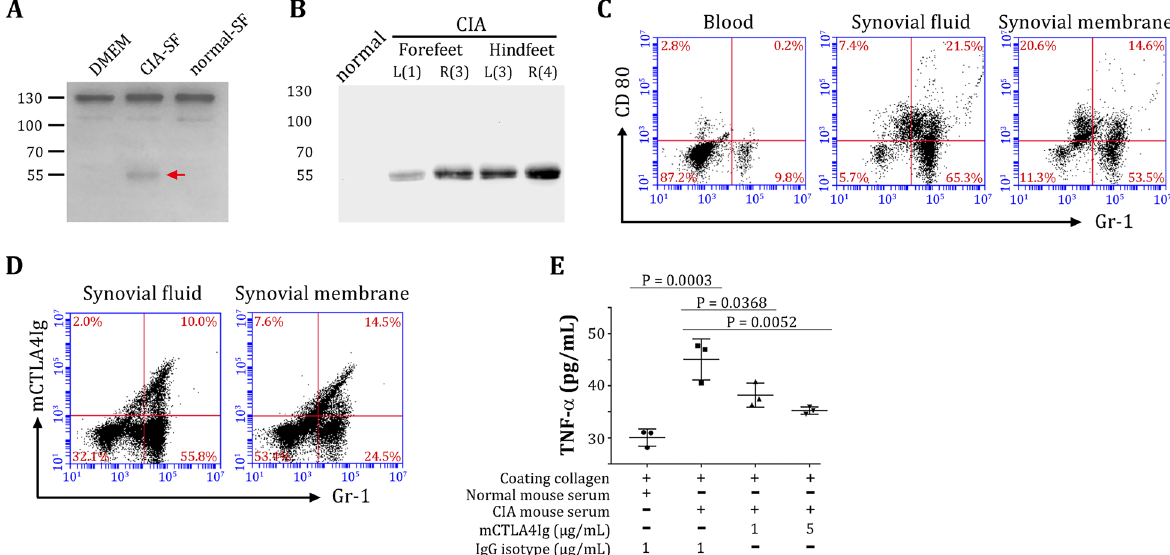
Fig. 6 Conversion of mAlb‑CTLA4Ig to mCTLA4Ig in the joints of mice that developed collagen‑induced arthritis (CIA). A mAlb‑CTLA4Ig was added to DMEM, CIA synovial fluid (CIA‑SF) lavage, or normal synovial fluid (normal‑SF) lavage. Conversion of mAlb‑CTLA4Ig (~ 130 kDa under reducing condition) to mCTLA4Ig (red arrow, ~ 55 kDa under reducing condition) was detected by western blot using an anti‑mouse CTLA4 antibody. B mAlb‑CTLA4Ig was injected into CIA mice or normal mice for 24 h. Paws were harvested, homogenized, and analyzed by western blotting using an anti‑mouse CTLA4 antibody. Positions of paws are indicated by capitalized letters R and L. Numbers in parentheses indicate the disease scores of the paws. C Synovium‑infiltrating cells were isolated from CIA mice and analyzed for Gr‑1 and CD80 expression by flow cytometry. Approximately 1/3 of the GR‑1 + cells in the synovial fluid and ~ 1/5 of the GR‑1 + cells in the synovial membranes expressed CD80, whereas blood GR‑1 + cells did not express CD80. D Synovium‑infiltrating cells were isolated from CIA mice and tested for mCTLA4Ig binding by flow cytometry. E Effect of in vitro mCTLA4Ig treatments on TNF‑α secretion by joint‑infiltrating cells stimulated with precoated collagen‑antibody